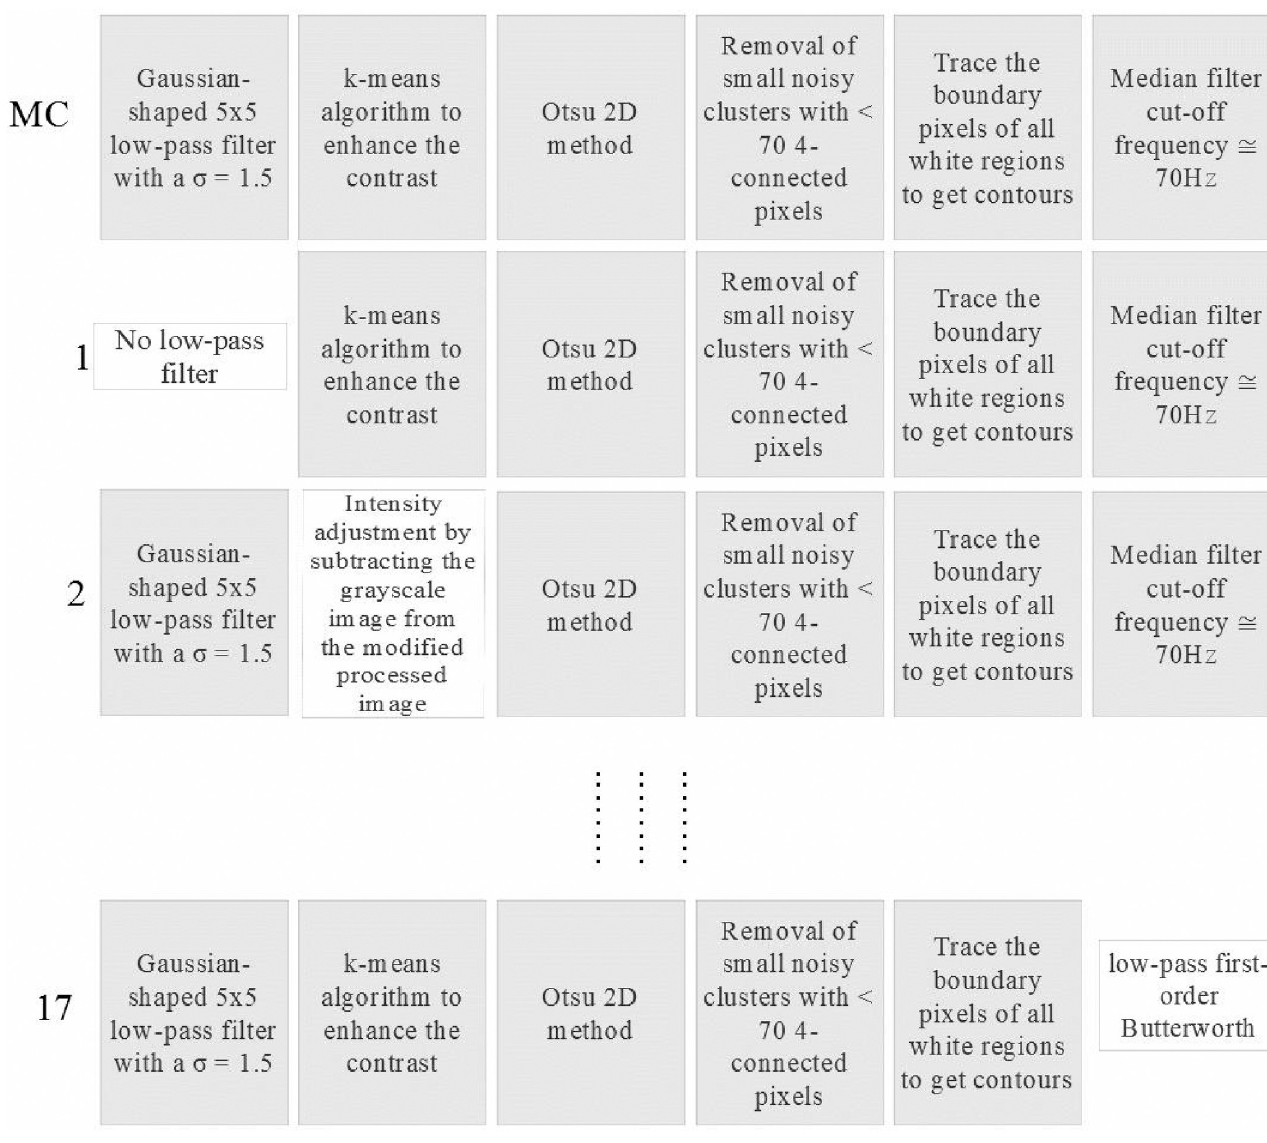
PLOS ONE | https://doi.org/10.1371/journal.pone.0248114 April 28,